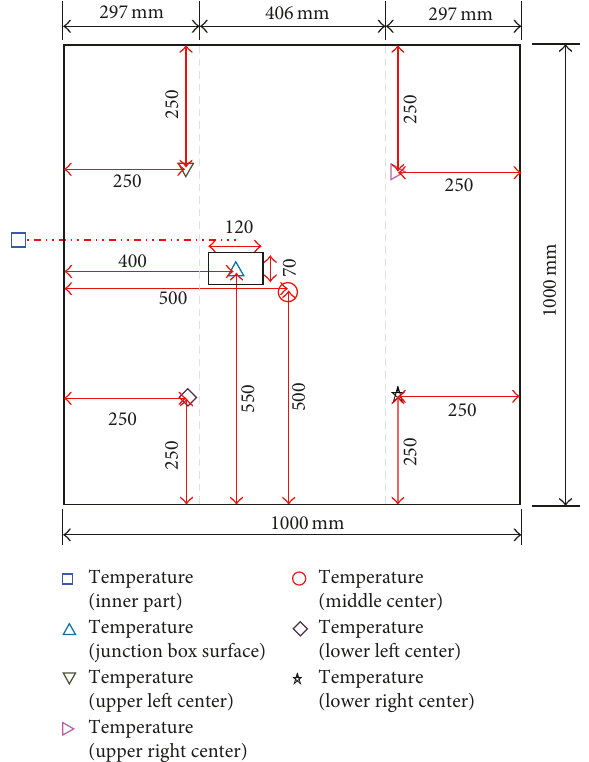
Figure 7: Test 2 and Test 3: the unexposed surface of the specimen and geometry of the thermocouple.